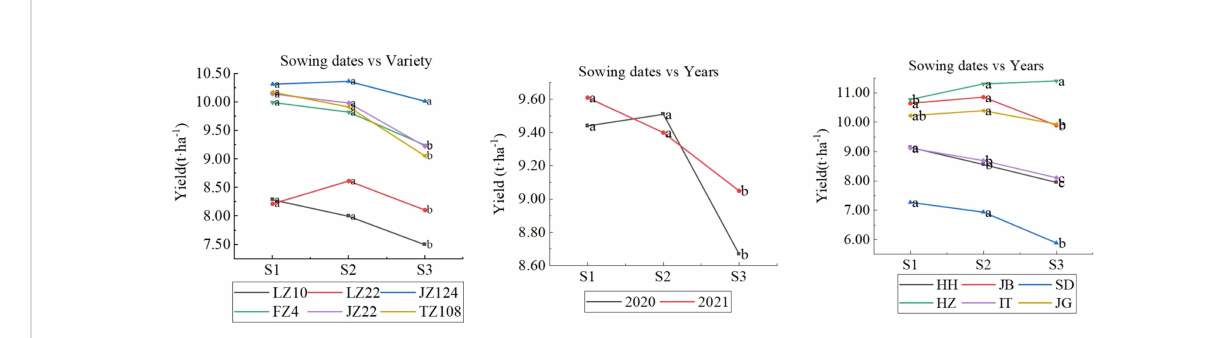
FIGURE 8 Interactions between sowing dates and variety (left), years (mid), and locations (right). Letters a, b and c are used to label the difference signi fi cance at 0.05; the same letter means not signi fi cant (NS), and a different letter means signi fi cant among the three sowing